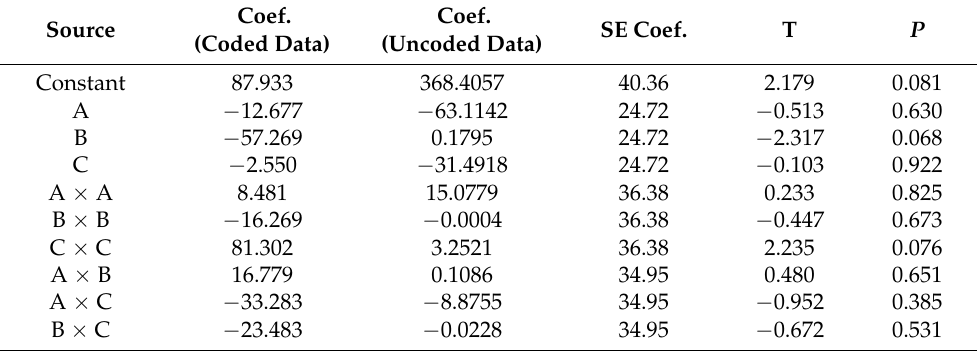
Table 3. ANOVA table of air permeability of the cotton face for the different parameters (S = 69.91; R 2 = 71.6%). Coef. Coef. Source